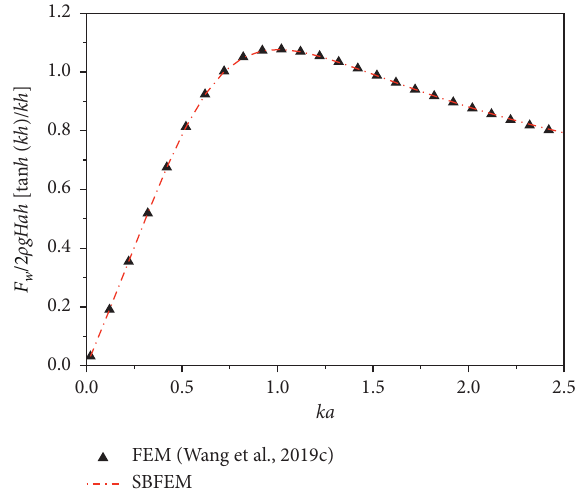
Figure 5: The total wave force on a circular cylinder for the FEM [33] versus SBFEM.